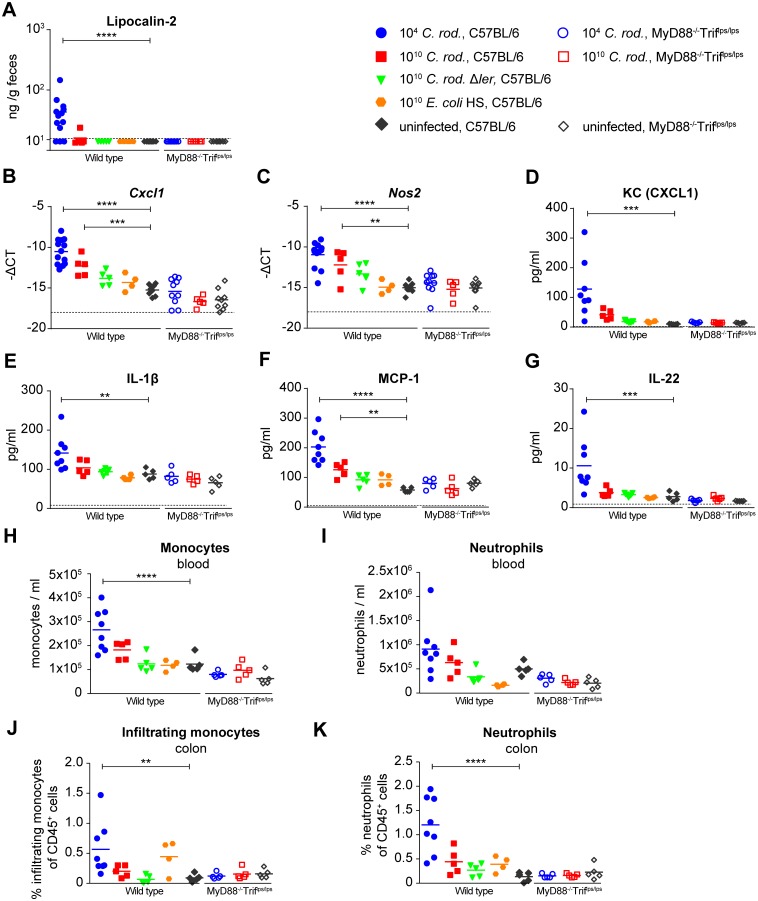
Early C. rodentium-induced innate immune response.(A) Lipocalin-2 quantification by ELISA in feces of germ-free mice infected for 18 h with 104 CFU C. rodentium (blue circles), 1010 CFU C. rodentium (red squares), 1010 CFU C. rodentium Δler (green triangles), 1010
E. coli HS (orange hexagons) or left uninfected (grey diamonds). MyD88-/-Triflps/lps germ-free mice were infected for 18 h with 104 CFU C. rodentium (open blue circles), 1010 CFU C. rodentium (open red squares), or left uninfected (open grey diamonds). N = 4–13 per group. Data were pooled from 3 independent experiments. (B and C) Gene expression levels of Cxcl1 (B) and Nos2 (C) in the distal colon of infected mice as determined by qPCR. (D-G) Cytokine protein levels in the distal colon of infected mice as determined by Luminex technology. (H and I) Leukocyte analysis by flow cytometry of peripheral blood. Monocytes were defined as CD45+, CD11b+, CD115+ population (H). Neutrophils were defined as CD45+, CD11b+, Ly6G+ population. Quantities are expressed as absolute numbers of cells per mL blood. (J and K) Large intestinal leukocyte analysis by flow cytometry. Infiltrating monocytes were defined as CD45+, CD11b+, CD64-, LygG-, Ly6Chigh, and MHCII- population (J). Neutrophils were defined as CD45+, CD11b+, Ly6G+ population (K). Quantities are expressed as percentages of leukocytes (of CD45+ population). Dotted lines represent detection limit. ns, statistically not significant; *, p < 0.05; **, p < 0.01; ***, p < 0.001; ****, p < 0.0001; groups were compared with the matching uninfected control group; statistical tests: Kruskal-Wallis (A), and 1-way ANOVA (B-K).